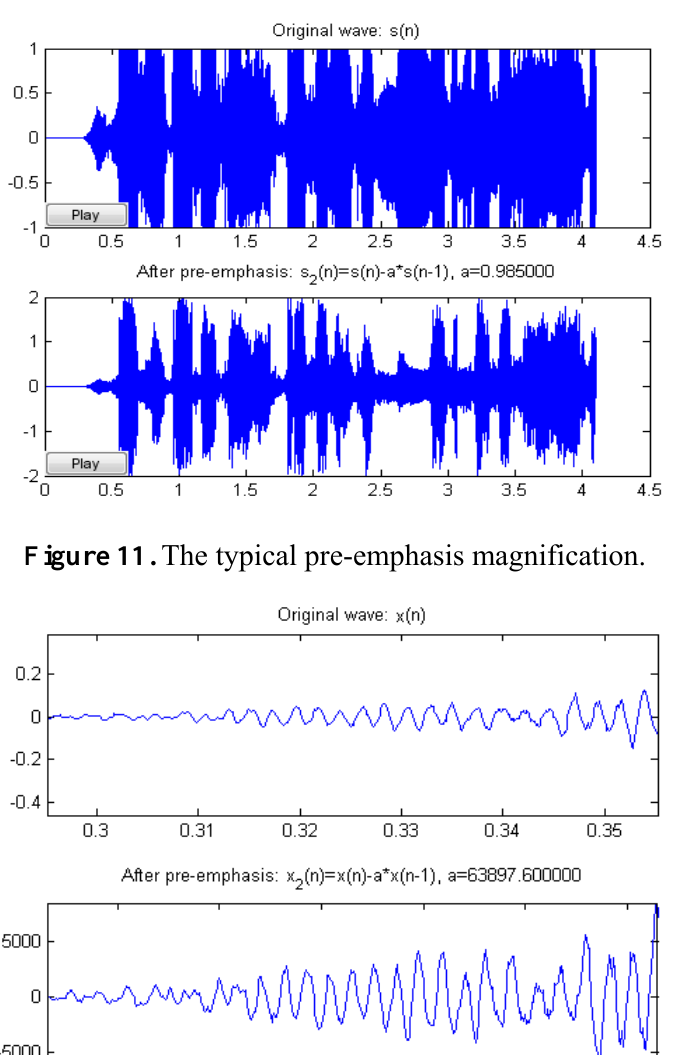
Figure 10. Original wave compare with Humaning Windows.